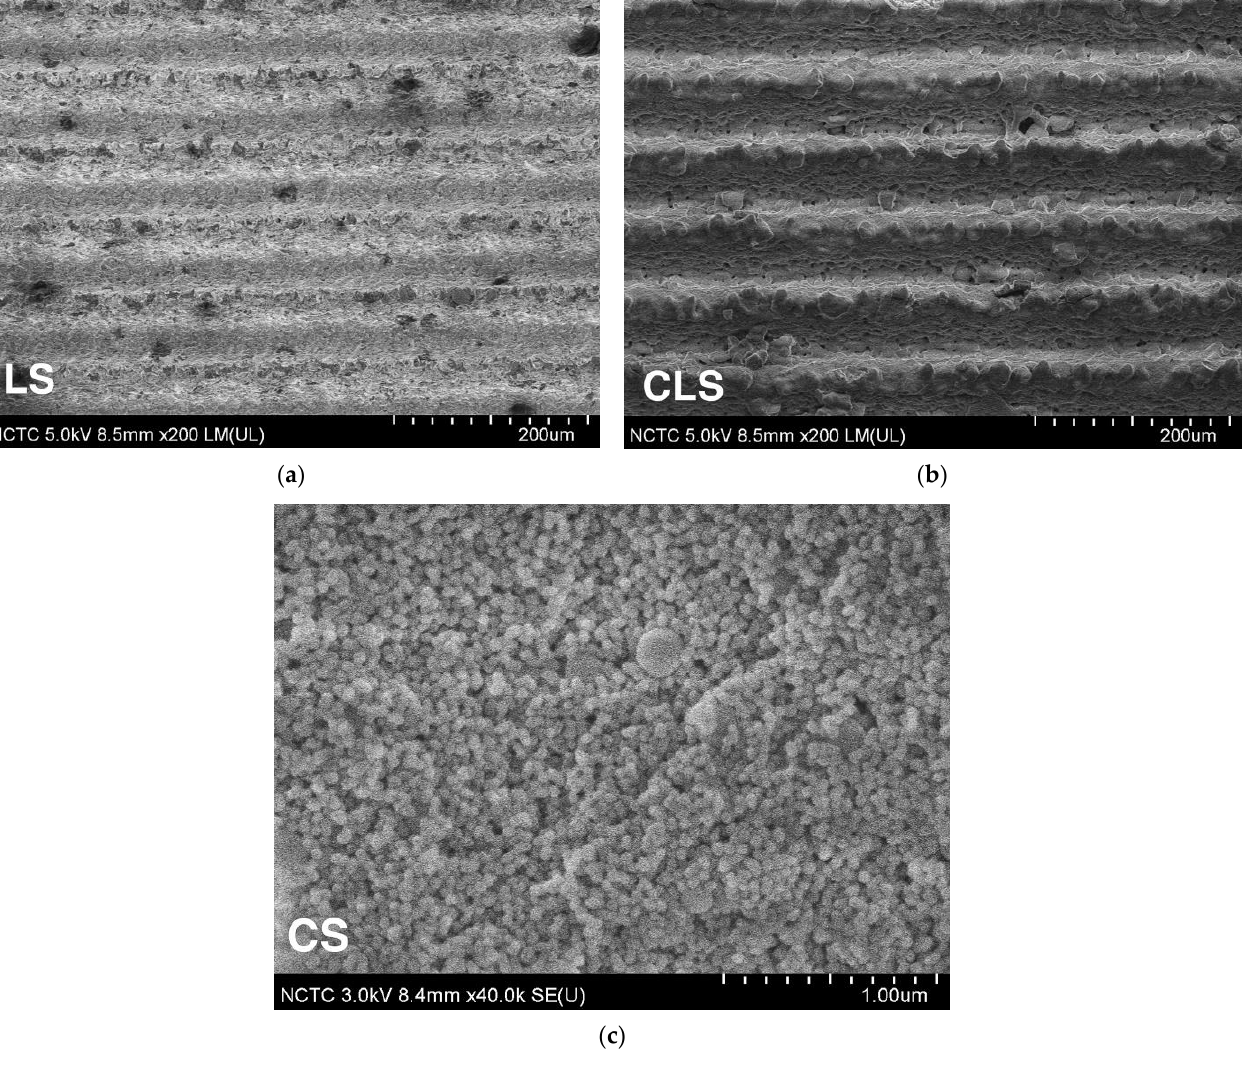
Figure 4. SEM images of ( a ) LS, ( b ) CLS, and ( c ) CS.